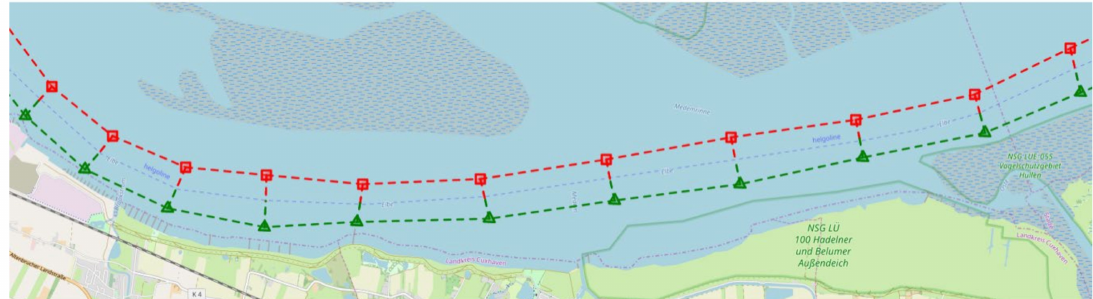
Figure 7. Excerpt of the created waterway grid for the Elbe River.